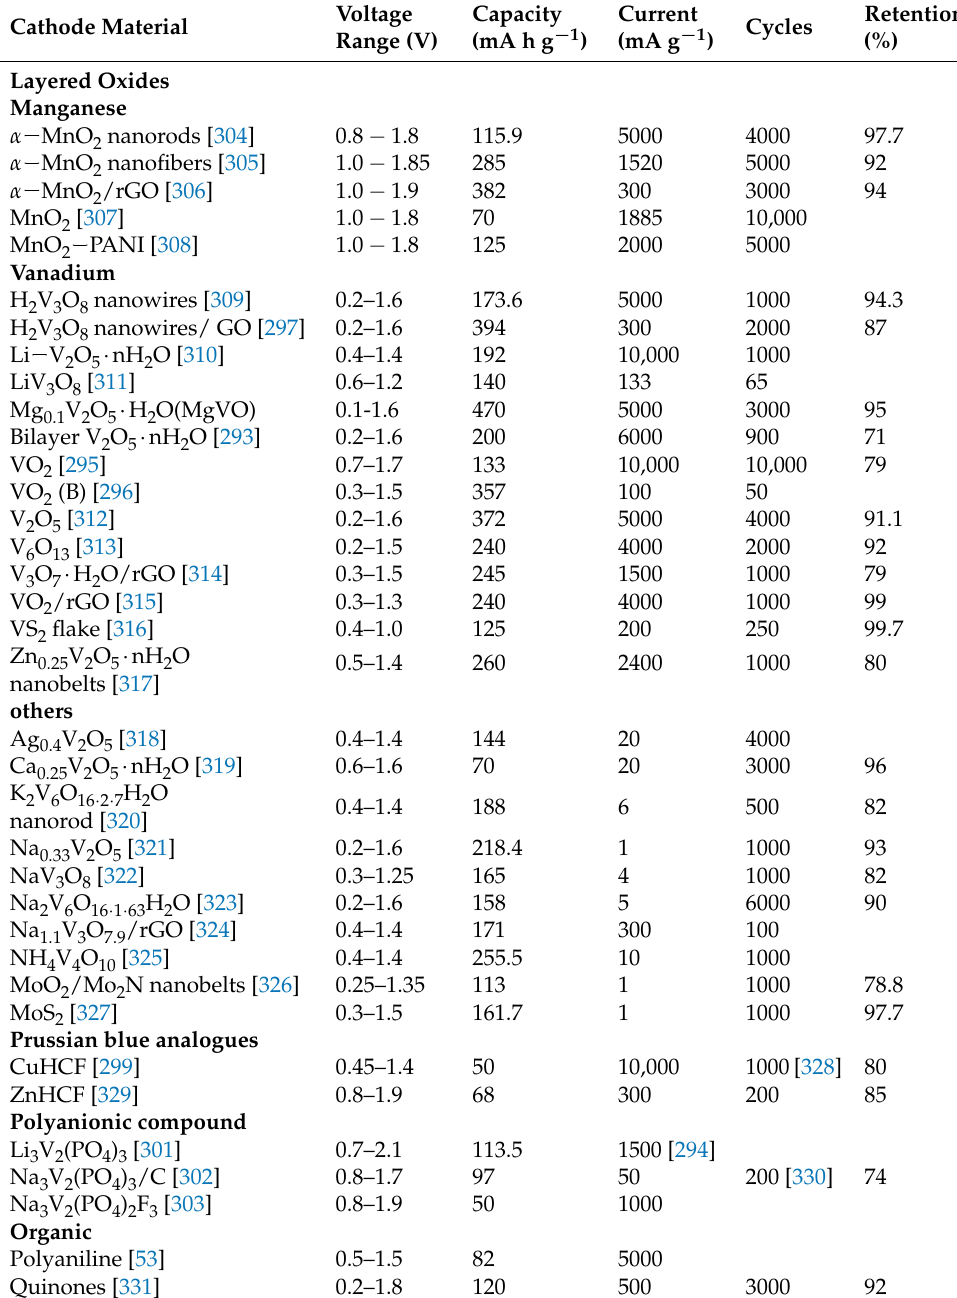
Table 11. Cathode materials for Zn-based batteries. Cathode Material Layered